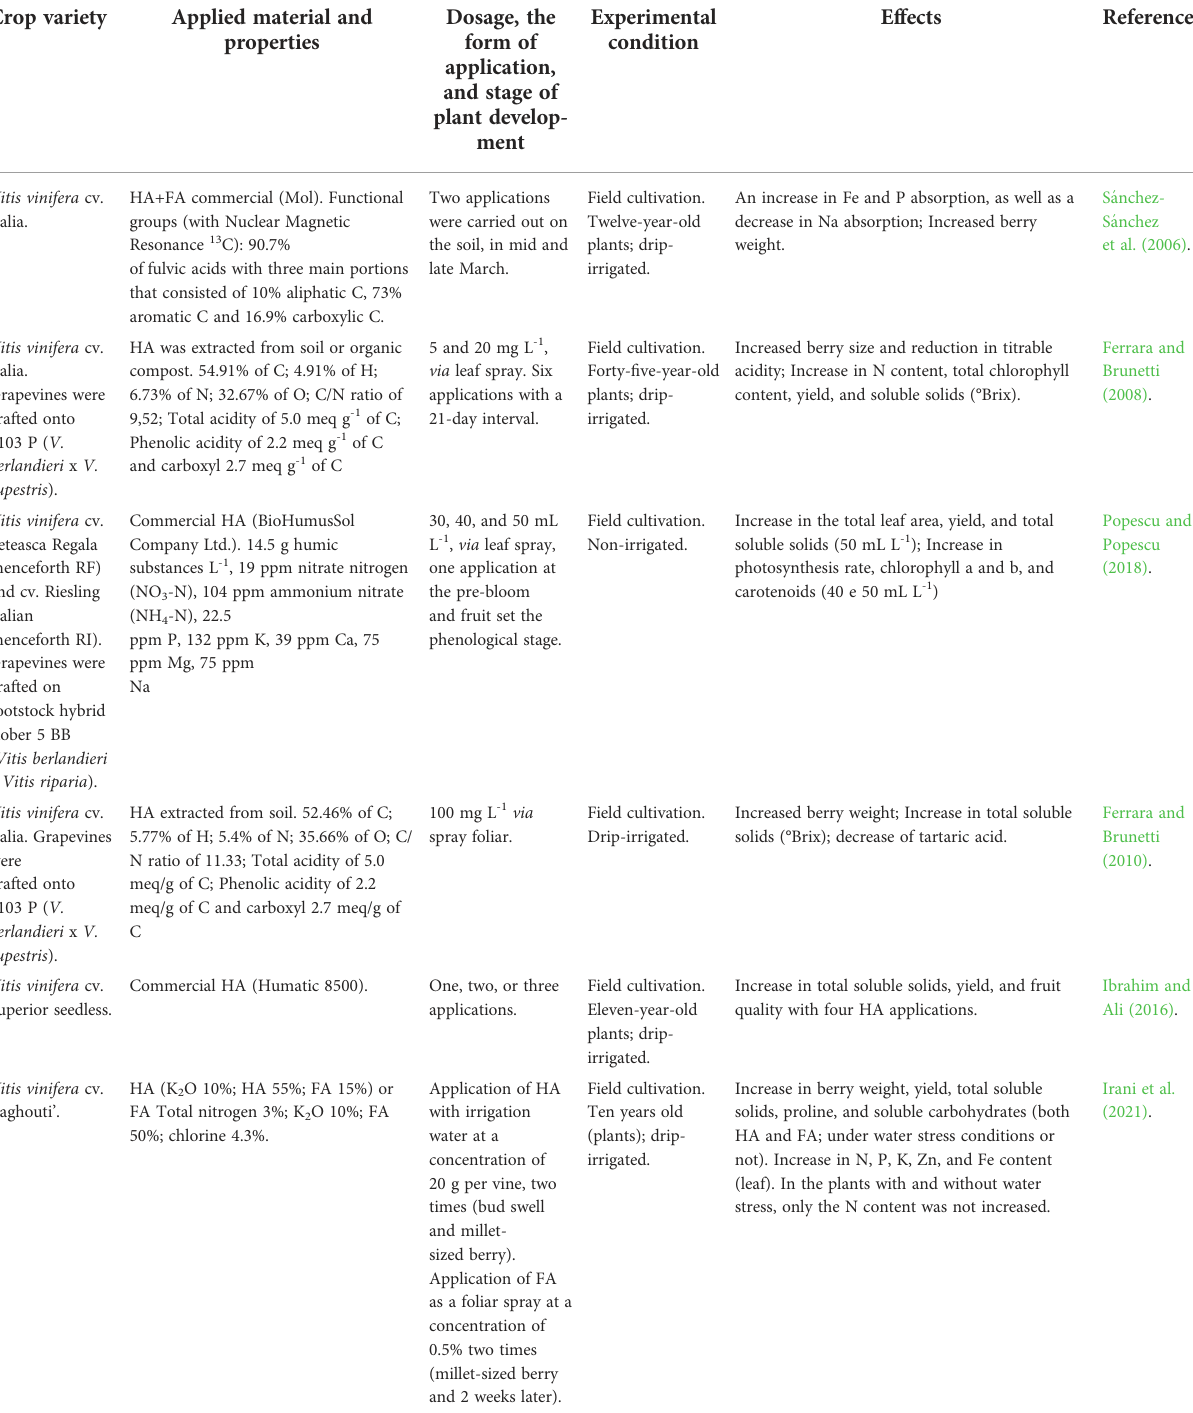
TABLE 3 An overview of the main effects of humic substances (HS) applied in